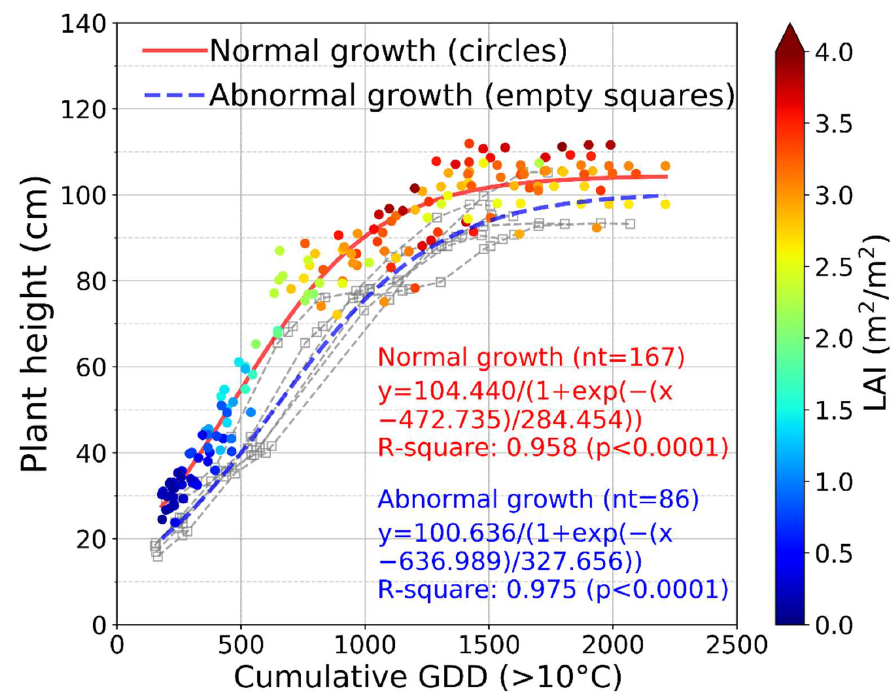
Figure 9. Relationship between cumulative growing degree days (GDD) and plant height. The color indicates leaf area index (LAI). Circle scatters indicate normal growth samples (number of samples = 167), and gray empty square plots indicate abnormal growth samples (number of samples = 86).